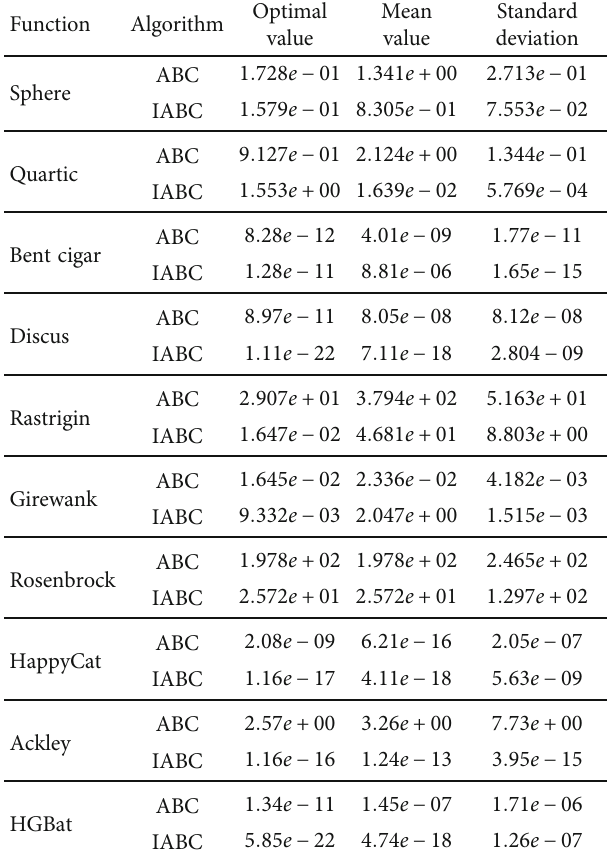
Table 4: Performance comparison of ABC algorithm and IABC algorithm in 50-dimensional